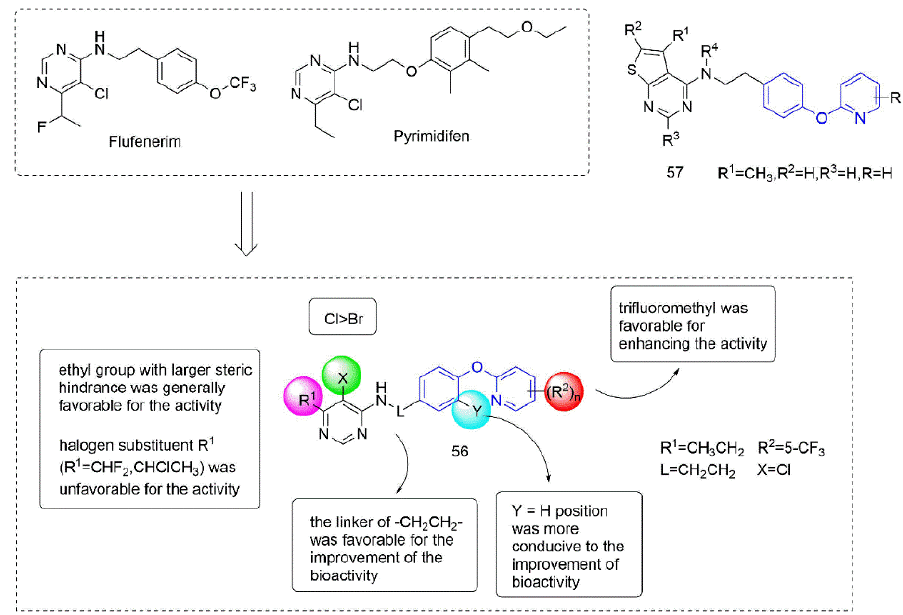
Figure 12. Complex I inhibitors (4-aminopyrimidine) containing phenoxypyridine. Pyrazole-5-carboxamide insecticides 58 (Figure 13) containing an azo structure were